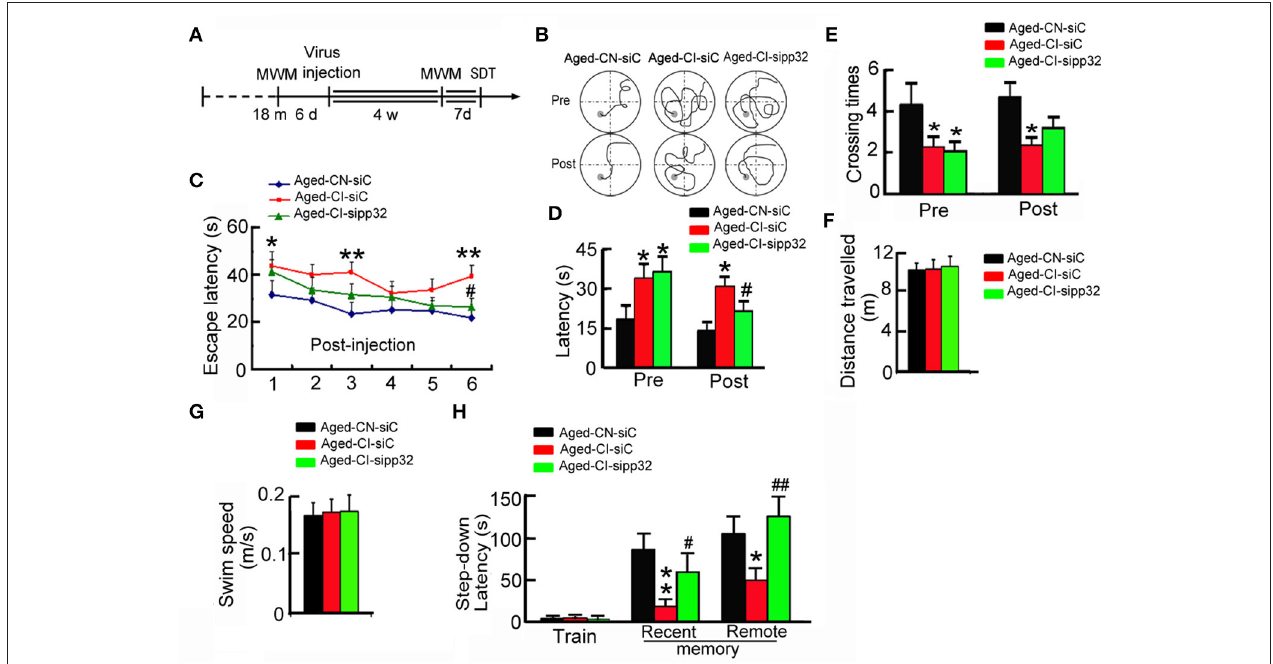
FIGURE 3 | Silencing pp32 improves learning and memory in Aged-CI mice. (A) Schematics of experimental procedure for aged mice. (B) Representative swim traces of mice in training of MWM task. (C) Escape latencies in MWM task of Aged-CN-siC, Aged-CI-siC, and Aged-CI-sipp32 animals. (D,E) . Latencies to find the platform (D) , and times crossing the place (E) where placed the platform during the test. (F,G) Distance traveled and swim speed of Aged-CN-siC, Aged-CI-siC and Aged-CI-sipp32 animals in the MWM task. No significant difference was observed among the Aged-CN-siC, Aged-CI-siC, and Aged-CI-sipp32 mice. (H) Recent and remote memory were detected by step-down avoidance test. N = 11 for each group. * p < 0.05, ** p < 0.01 vs. Aged-CN-siC; # p < 0.05; ## p < 0.01 vs. Aged-CI-siC (mean ± SEM).